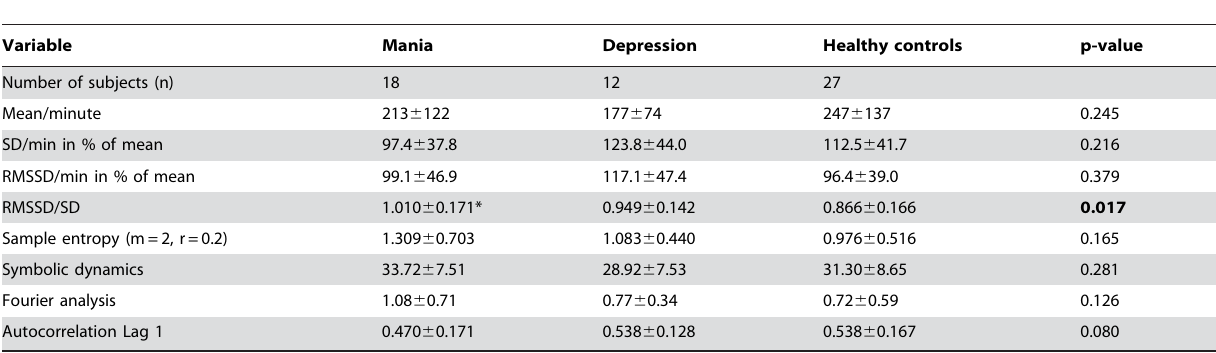
Table 5. Results from 64-minute period of continuous motor activity in the evening.